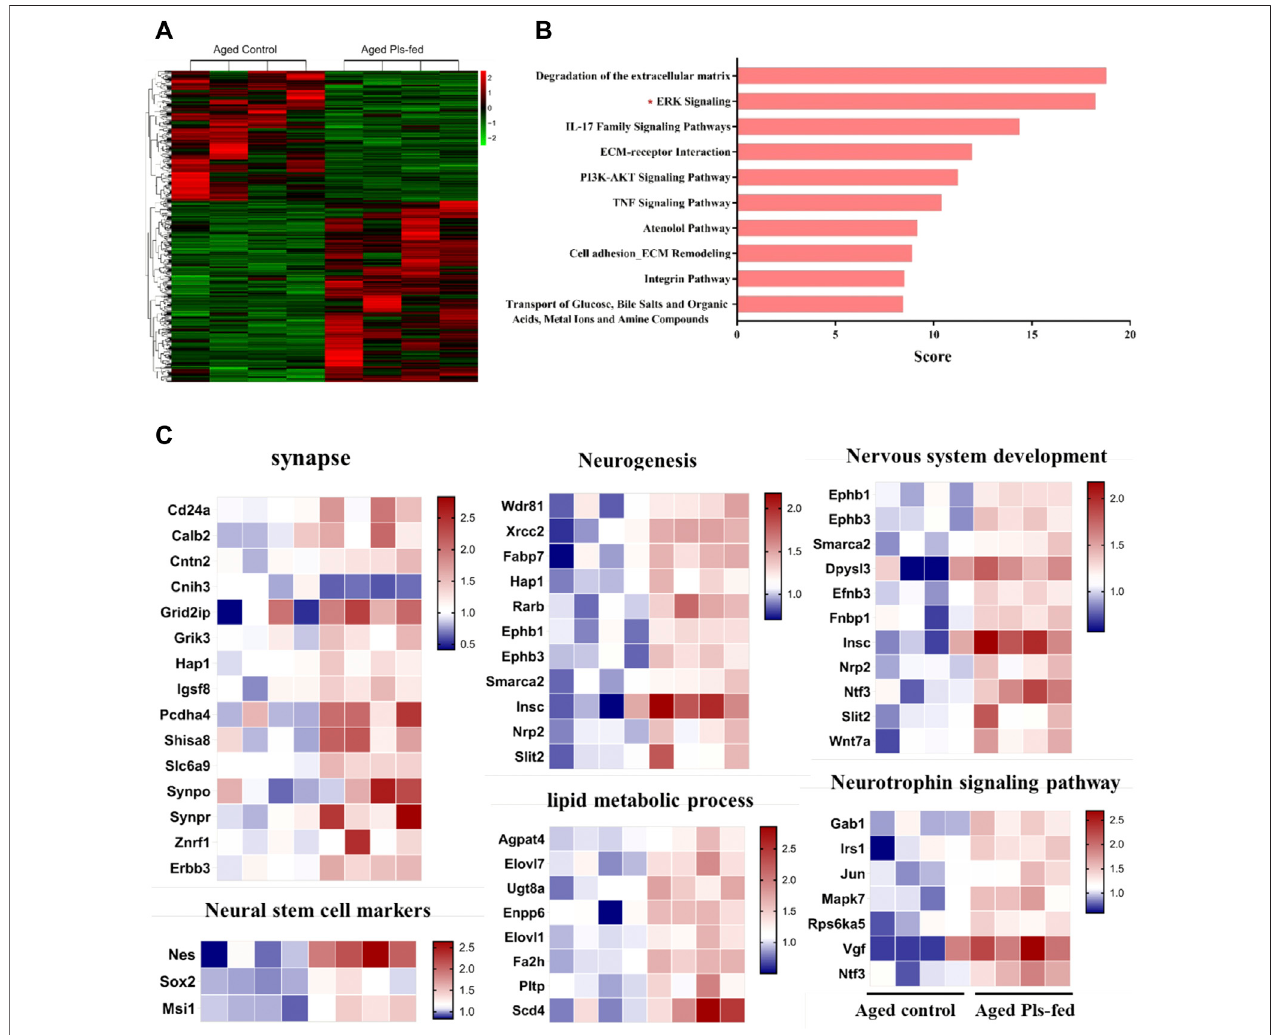
FIGURE4| Transcriptomics pro fi leofhippocampusinaged Pls-fedmice. (A) Aheatmap showsall differentially expressed genesinaged controlversusagedPls- fed murine hippocampus based on RNA-seq ( n = 4 mice per group). (B) GeneAnalytics pathway analysis of differentially expressed genes in hippocampus of aged control vs. aged Pls-fed mice, the top ten pathways are highlighted here. (C) Plasmalogen treatment changed the transcriptomics pro fi le of hippocampus in the aged mice. ( n = 4 mice per group).